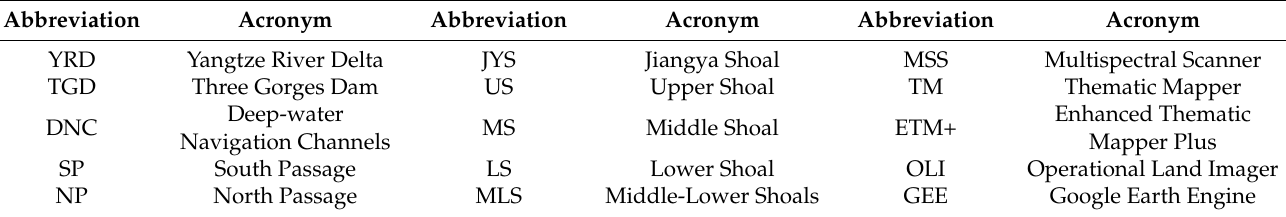
Table A1. Abbreviations and